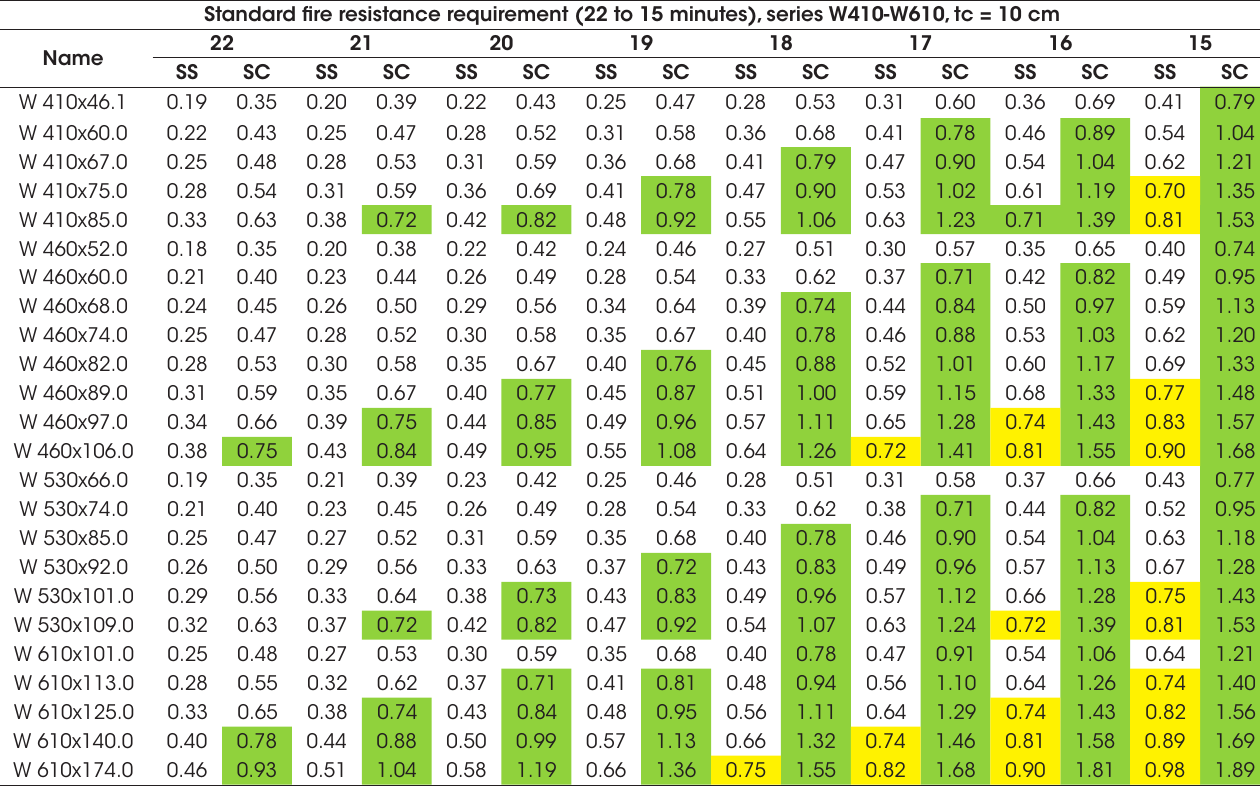
Load factors as function of the standard fire resistance requirement for composite beams with 10 cm slab and Gerdau profile series W410-W610